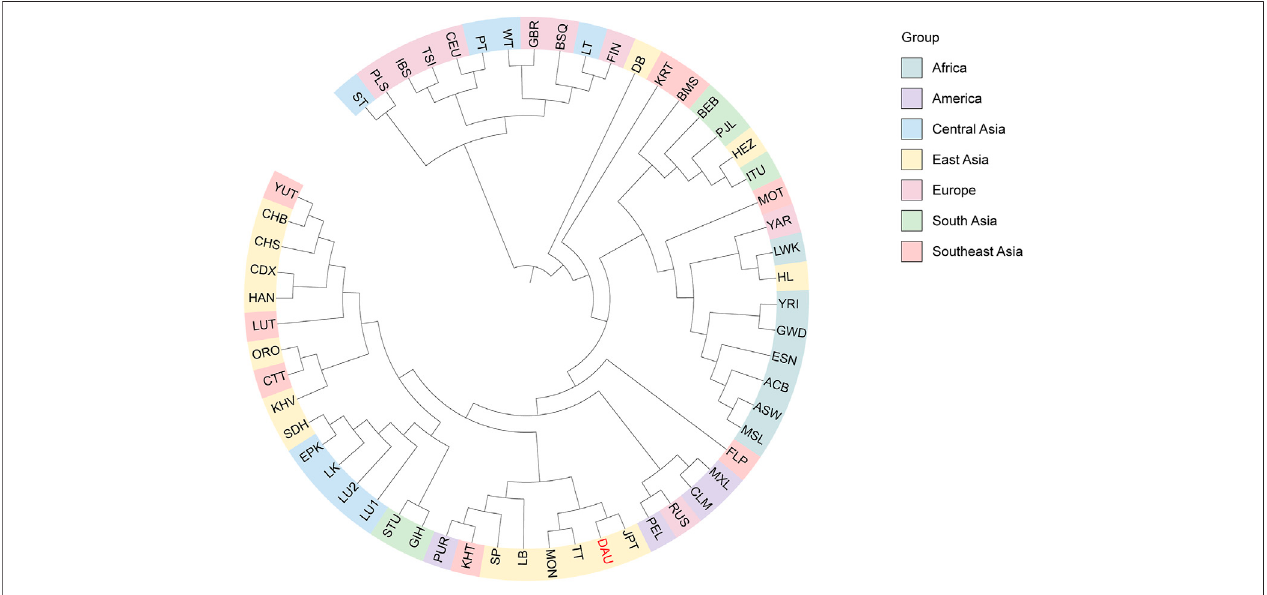
FIGURE8| ThephylogeneticUPGMAtreefortheDuarethnicgroup(DAU)and56referencepopulations.Thetreeiscoloredaccordingtogeographicorigins.DAU is highlighted in red.